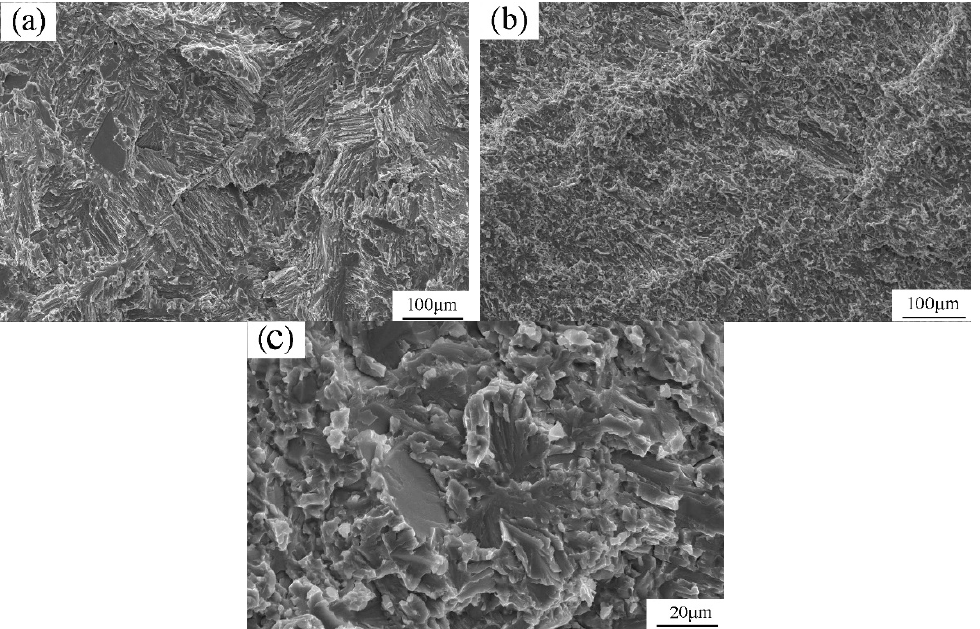
Figure 12. Fractographs of tensile specimens: ( a ) CJ with 150× magnification; ( b ) FJ with 150× magnification; ( c ) FJ with 800× magnification.